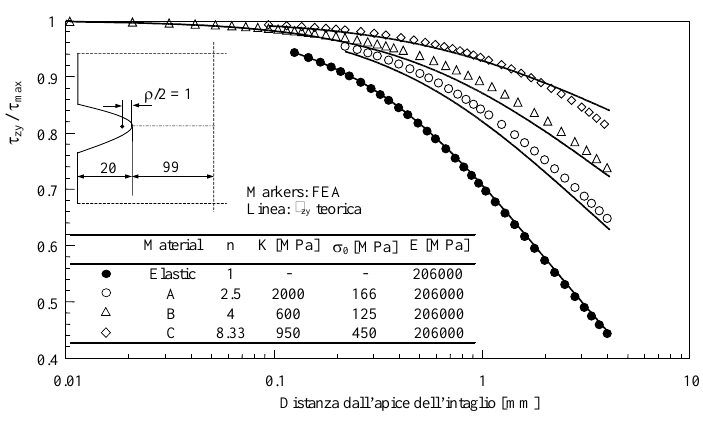
τ lungo la bisettrice dell’intaglio per differenti materiali, Figura 15: Componenti di tensione zy normalizzate rispetto alla tensione massima